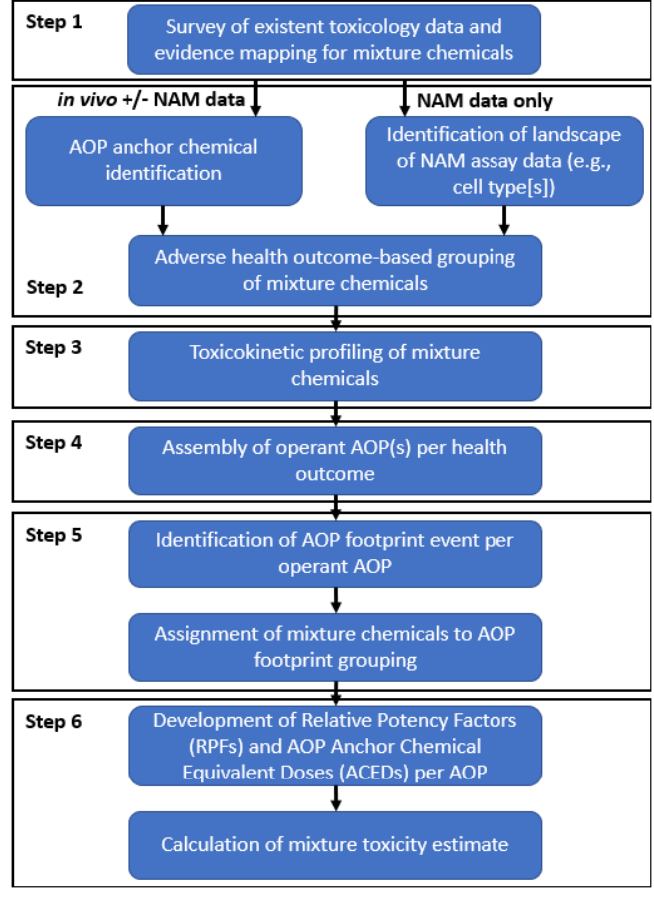
Figure 1. AOP footprinting workflow. The general workflow starts with the assembly of all available in vivo toxicity and in vitro NAM (e.g., cell-bioactivity; toxicogenomic) data and culminates in the calculation of a mixture risk estimate via the development and application of relative potency factors within each operant AOP identified for a given health outcome.